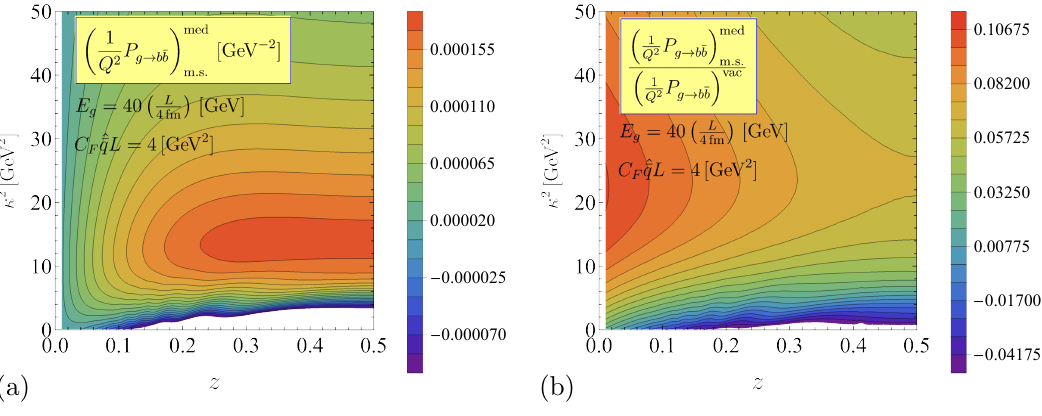
¯ b with m b = 4 . 18 GeV, and (b)